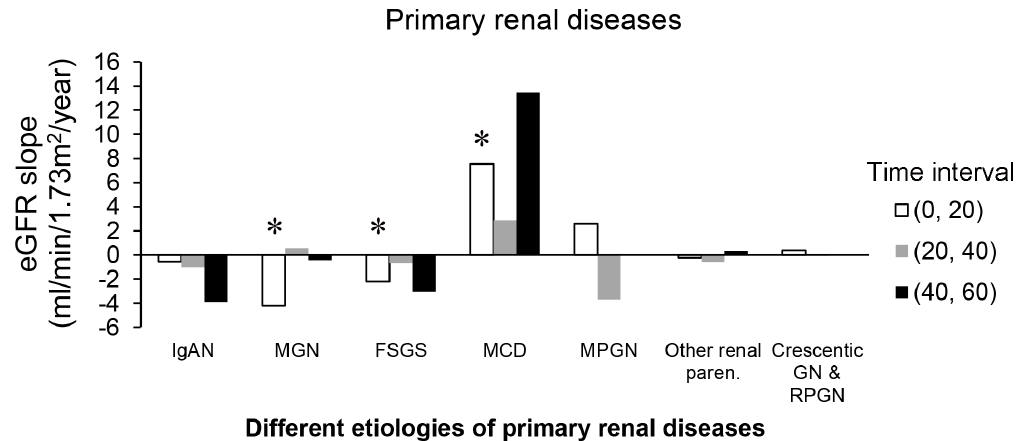
Figure 3. eGFR decline in primary renal diseases; IgAN, IgA nephropathy; MGN, membranous glomerulonephritis; FSGS, focal and segmental glomerulosclerosis; MCD, minimal change disease; MPGN, membranoproliferative glomerulonephritis; Other renal paren., other renal parenchymal disease; Crescentic GN& RPGN, crescentic glomerulonephritis and rapidly progressive glomerulonephritis (Significant codes: *, , 0.05 means the eGFR decline is a significant value during this time interval under